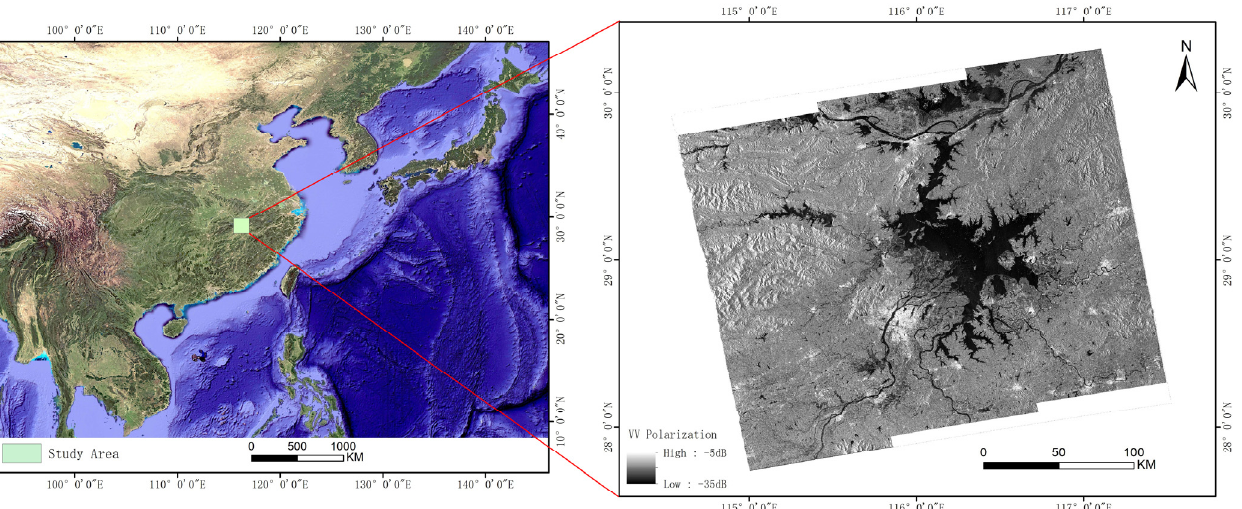
8 of 21 Table 1. Confusion matrix diagram.